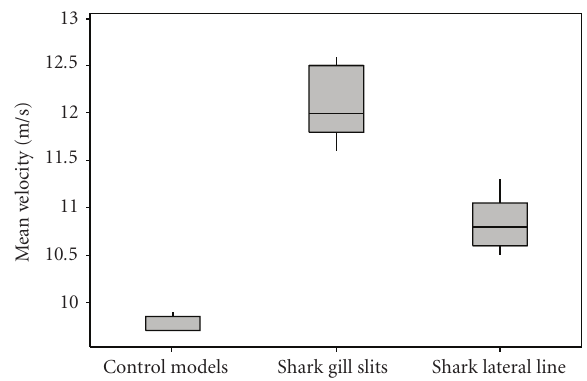
Figure 4: Mean velocity magnitude in the gill slit and lateral line regions of shark body and control